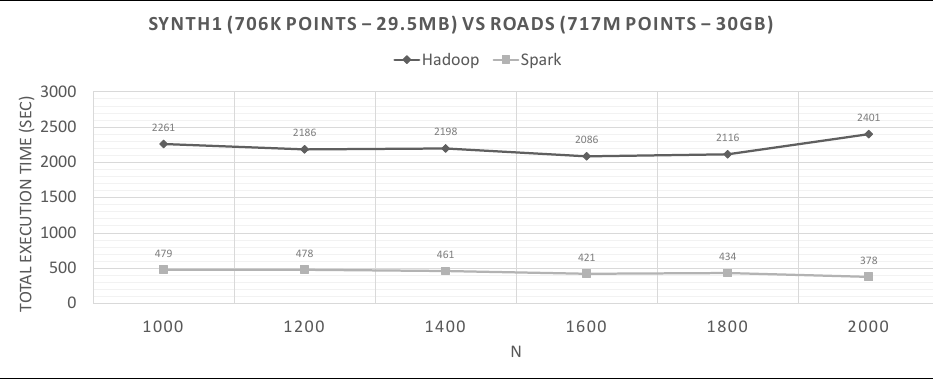
Figure 22. Hadoop vs. Spark, small synthetic query and large training datasets. In Figures 23–25 the small synthetic query is replaced by the large